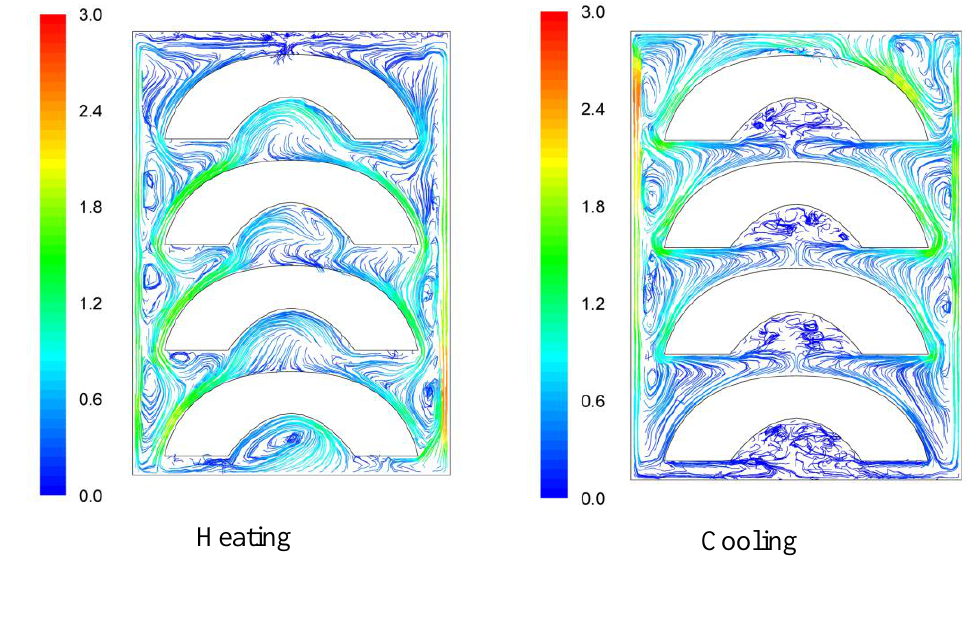
Figure 4. Velocity pathlines after 30 s of heating (left) and after 30 s of cooling (right) for the “downward” case (velocity in